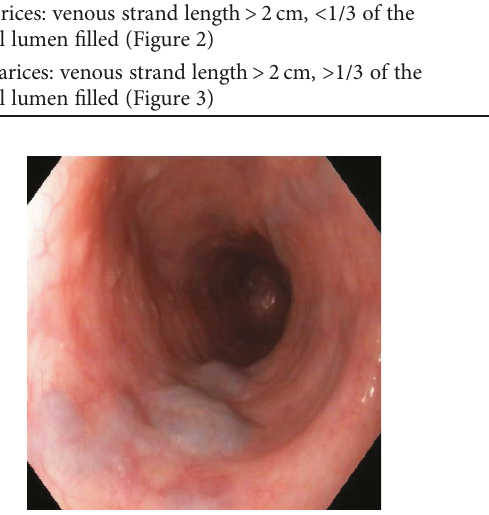
Figure 1: Type I downhill varices. Endoscopic appearance.